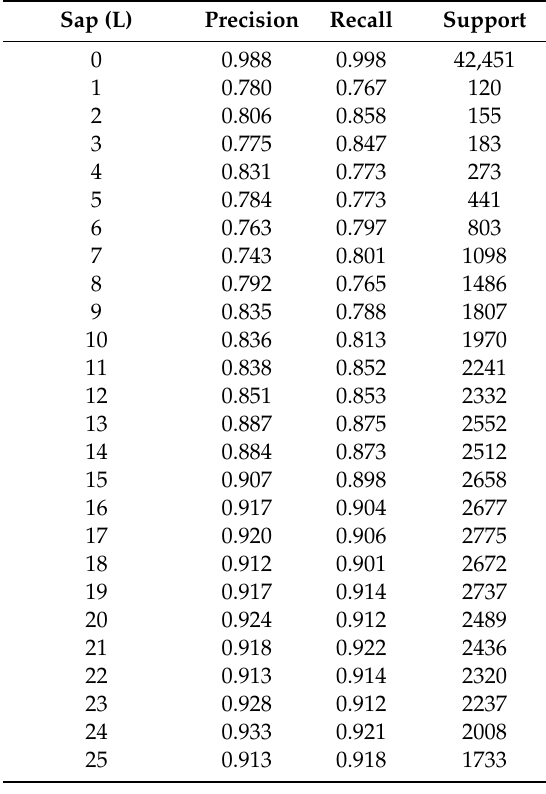
Table 6. Prediction accuracy of SVM optimal